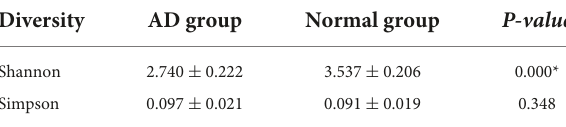
TABLE 3 Alpha diversity index of each